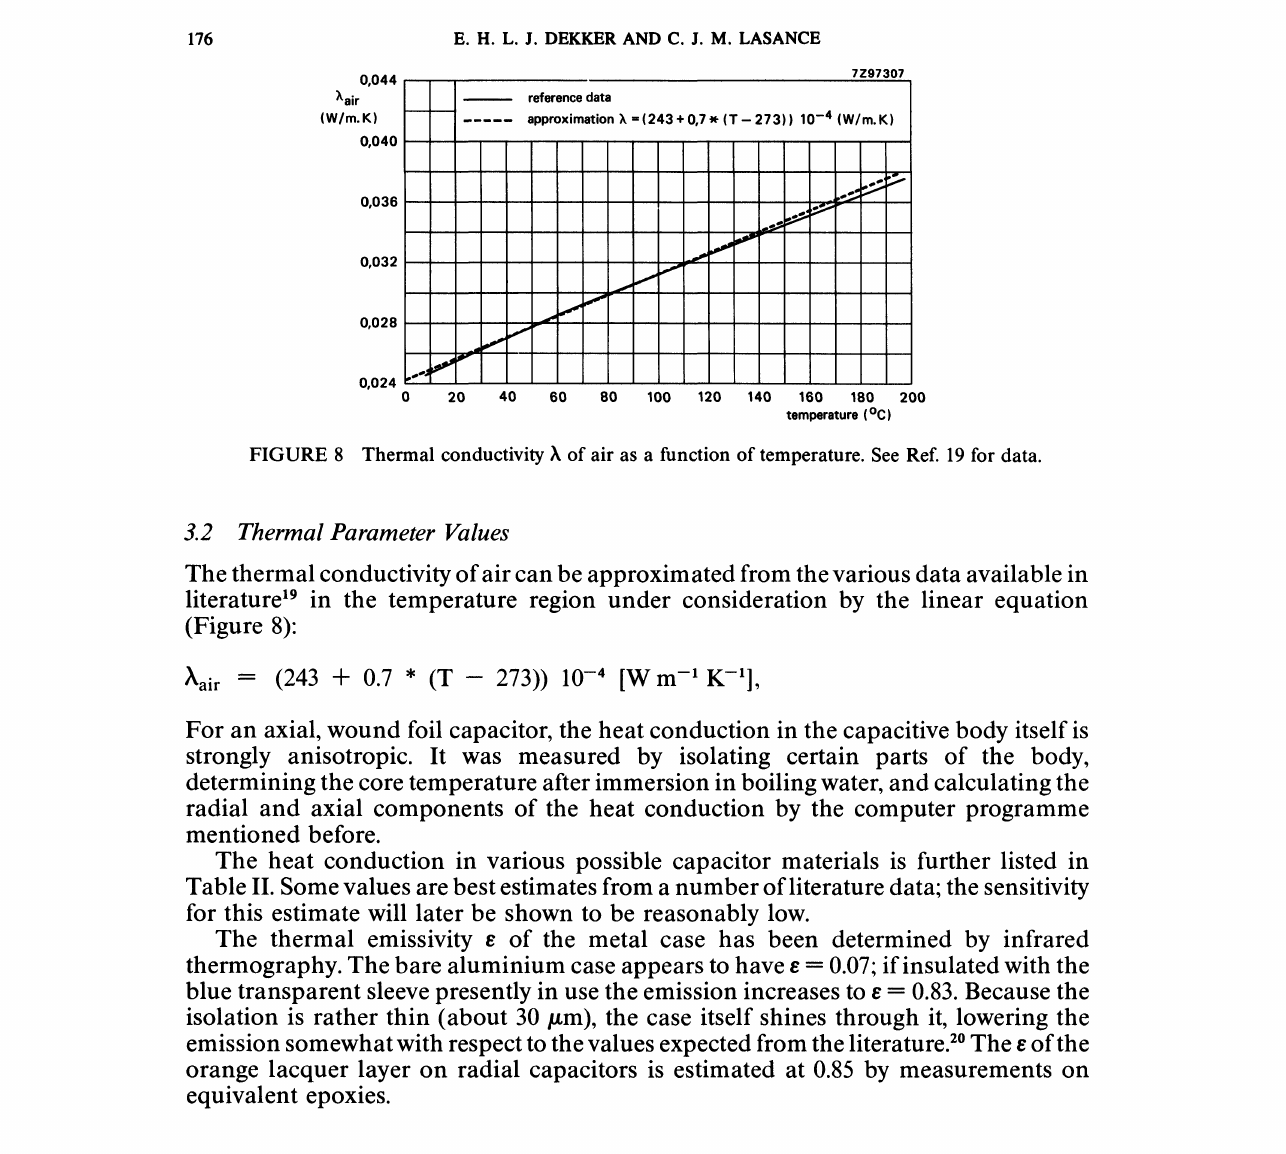
TABLE II Thermal conductivity h of various